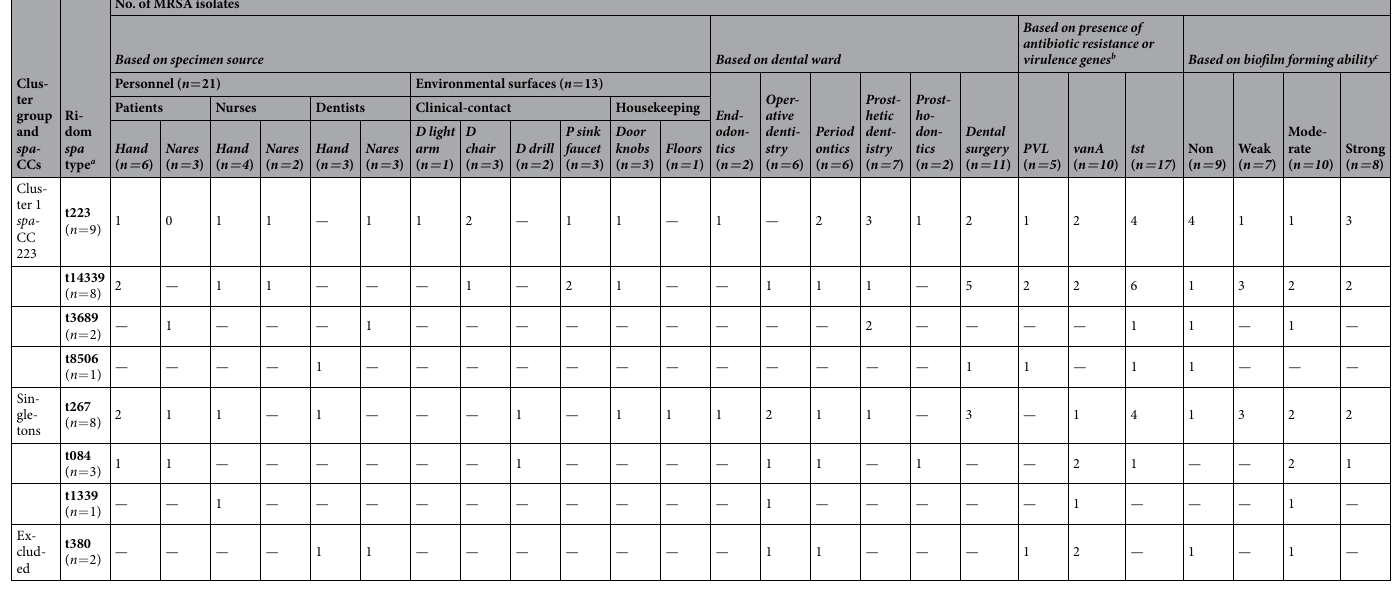
Table 5. Characteristics and detailed distribution of the spa -CCs and spa -types detected in this study. spa- CC: denotes spa clonal complex as determined by the Based Upon Repeat Pattern (BURP) algorithm in the Ridom StaphType software with a distance cost of ≤ 5; excluded: denotes entries excluded from BURP clustering because the spa repeat pattern comprised fewer than five repeats; D light arm : Dental light arm; D chair : Dentist’s chair; D drill : Dentist’s drill; P sink faucet : Patient’s sink faucet; PVL : The gene encoding the Panton– Valentine leucocidin toxin; vanA: the gene encoding an enzyme that causes a structural change in the terminal amino acid of the pentapeptide chain of peptidoglycan, thus conferring vancomycin resistance; tst : the gene encoding the toxic shock syndrome toxin; spa: staphylococcal protein A; a minus sign ( − ) denotes the absence of an attribute. a Nomenclature according to Harmsen et al . 91 ; the spa types shown are based on the Ridom StaphType software. b All the MRSA isolates investigated in the current study were mecA- positive and mecC- negative. C The isolates were classified as biofilm non-producers, weak, moderate, and strong biofilm producers based on previously published criteria 34